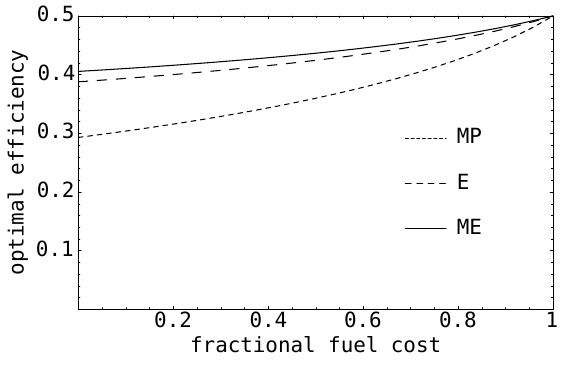
Figure 2. Comparison between optimum efficiencies for both maximum power and maximum ecological regimes (the former E function and the modified ME) for τ = 1 / 2